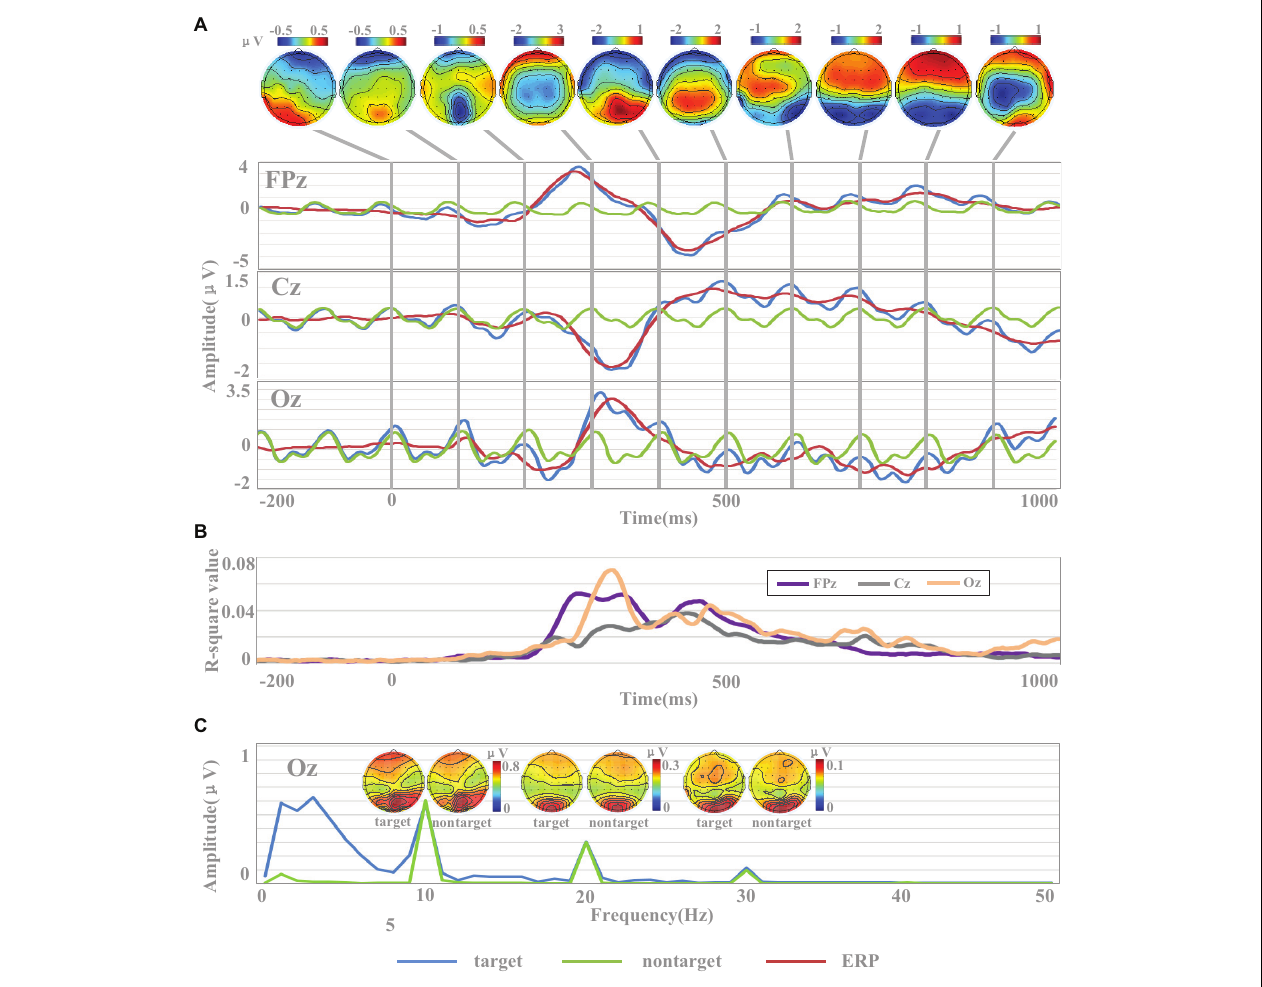
FIGURE 3 | Waveforms and amplitude spectrum of EEG. (A) The temporal waveforms of EEG [including target images, non-target images, and event-related potential (ERP) data] and the scalp topographies of amplitudes of ERP. (B) The r -square values in channels of FPz, Cz, and Oz. (C) Spectral characteristics of EEG for target and non-target